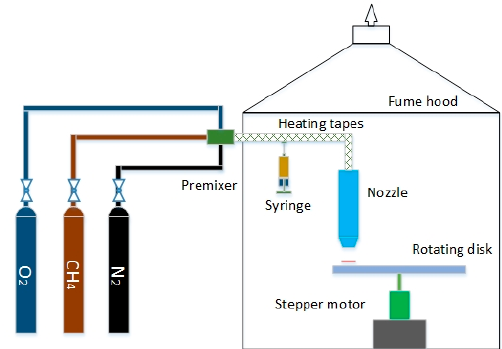
Figure 1. Schematic diagram of the experimental system using flame stabilizing on a rotating surface (FSRS) method